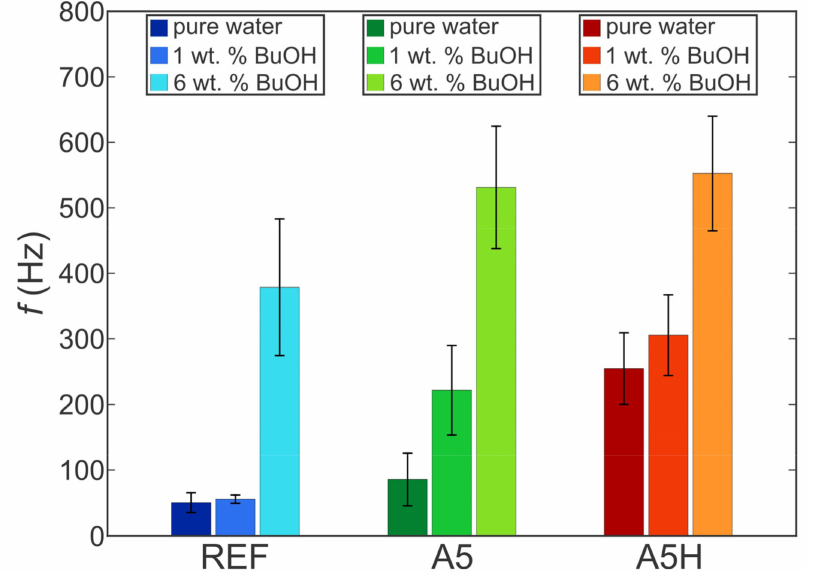
Figure 13. Bubble nucleation frequencies at 100 kW m − 2 on three different surfaces for boiling of either pure water or a water mixture containing 1 wt.% or 6 wt.%